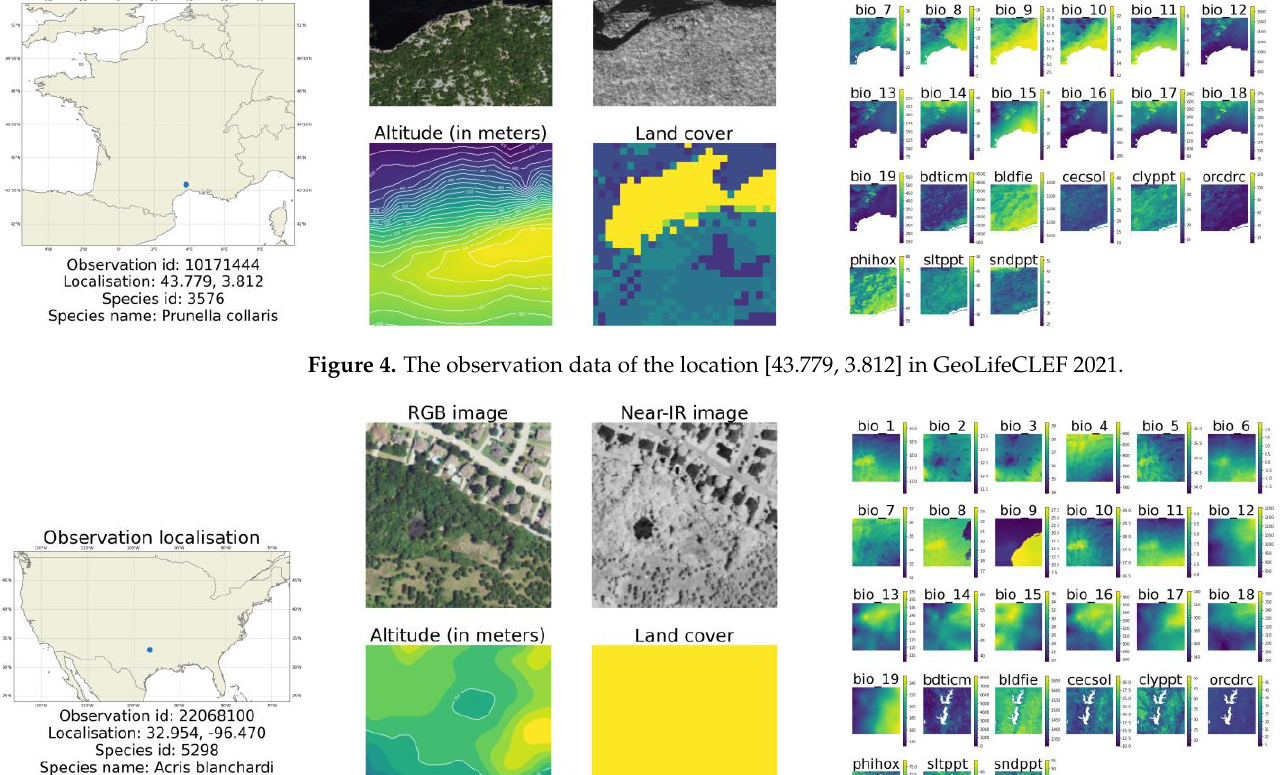
Table 2. The sample statistics of GeoLifeCLEF 2021 and